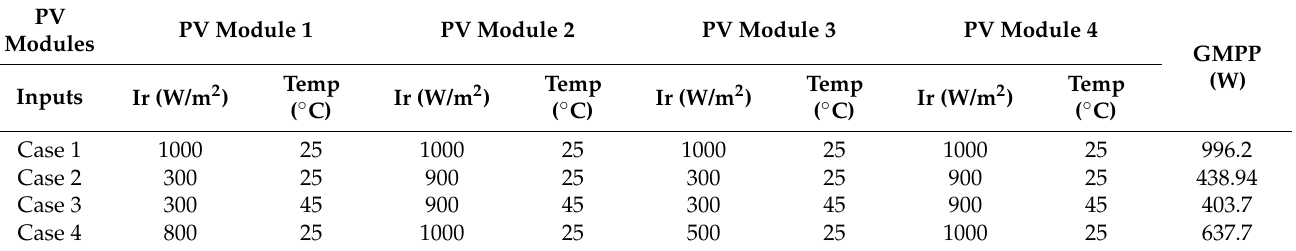
Table 3. Irradiance and temperature profile of all Cases.